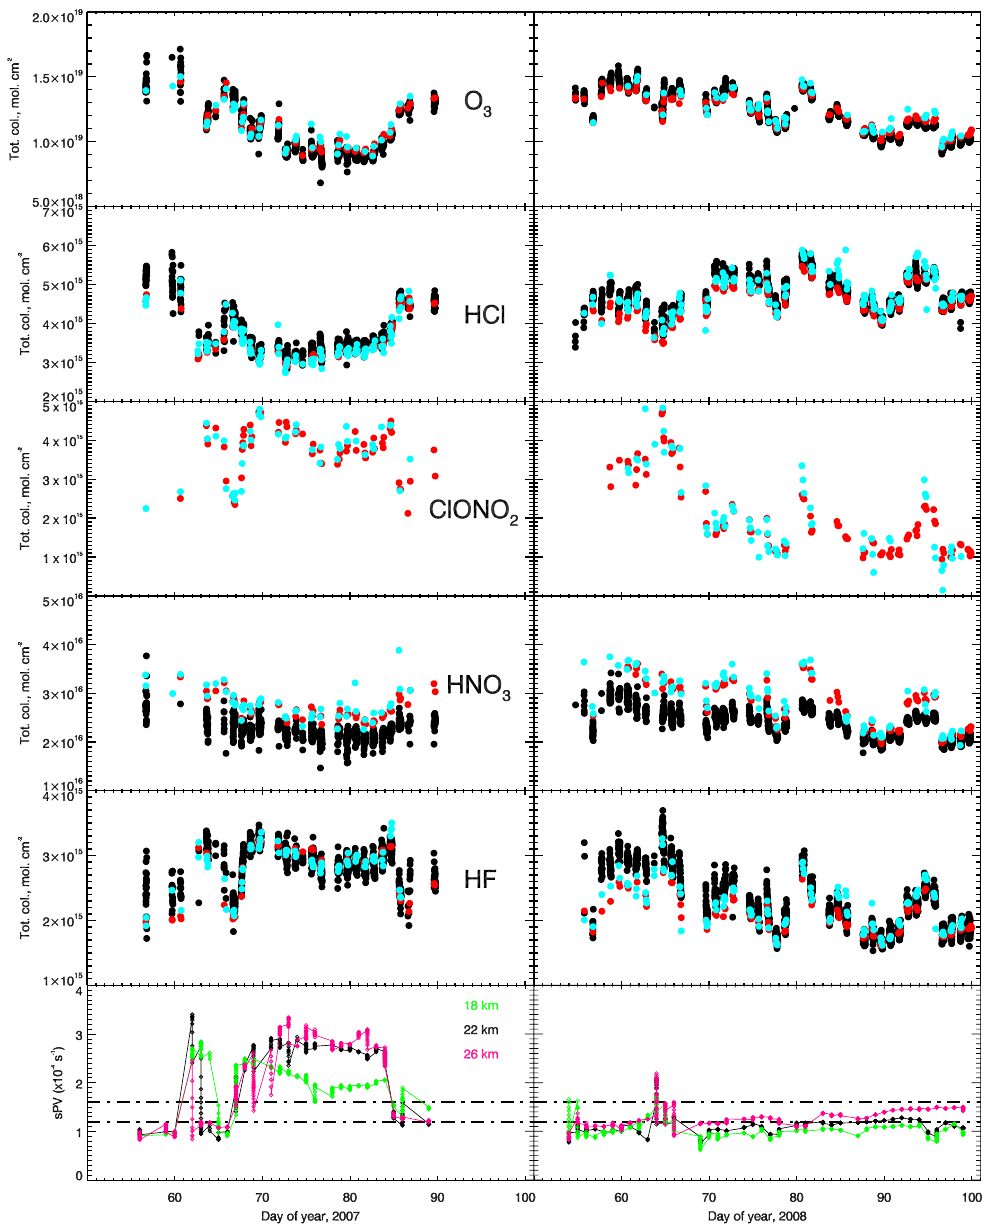
Fig. 1. Time series showing total column densities of (from top to bottom): O 3 , HCl, ClONO 2 , HNO 3 and HF for the 2007 (left panels) and 2008 (right panels) campaigns. 125HR measurements are shown in red, DA8 in cyan and PARIS-IR in black. The scaled potential vorticity (sPV) at 18, 22 and 26km is shown in the bottom panel for each year, with approximate locations of the vortex inner and outer edges marked by the dot-dashed lines. Error bars are omitted for clarity. See Table 1 for total